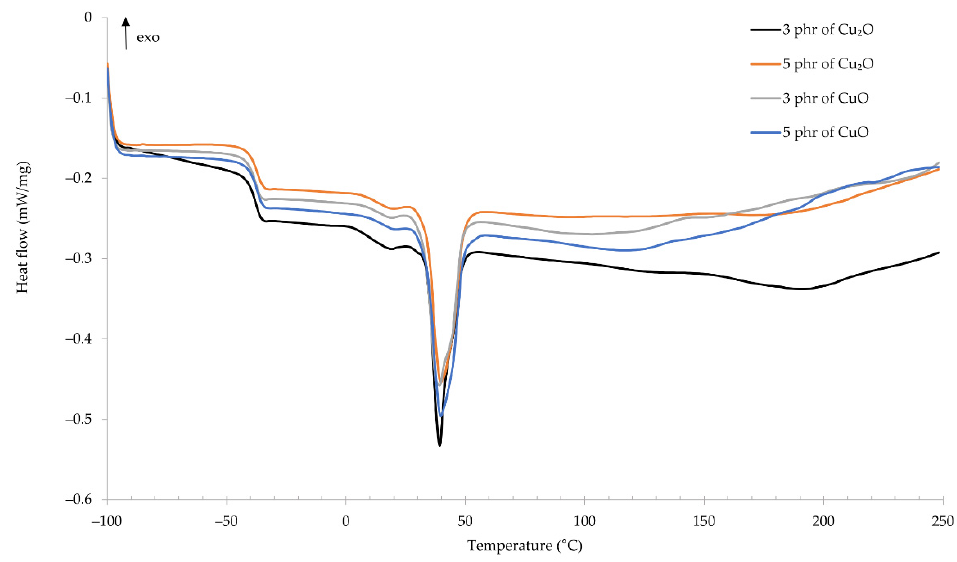
Figure 7. DSC spectrum of CR compositions; T = 160 °C, t = 45 min.